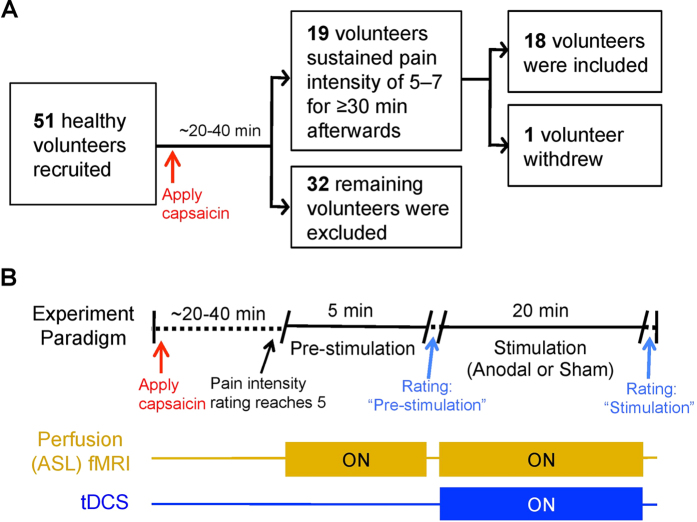
Experiment paradigm.(A) Fifty-one healthy volunteers were first screened for their response to topical application of 1% capsaicin cream on the right, medial calf. To achieve optimal temporal resolution, a continuous rating scale, anchored between 0 (none) and 10 (worst imaginable) was used to record the subject’s ongoing pain intensity. After capsaicin application for 20–40 minutes, only subjects who reached and maintained a tonic pain experience (pain intensity rating of 5–7 for ≥30 minutes; Supplementary Fig. 1) participated in the remainder of the study. One subject withdrew due to discomfort during a sham tDCS MRI session. (B) Eighteen capsaicin responders participated in two perfusion MRI sessions, one with anodal tDCS and one with sham tDCS, at least one week apart. The order of the experimental sessions was randomized and counterbalanced across the subject cohort. Capsaicin cream was applied as in the initial screening session. No subjects reported pain before the session commenced. Once the subject’s pain intensity rating reached a score of 5, which typically required 20–40 minutes, a 5-minute pre-stimulation ASL fMRI scan was performed followed by a 20-minute scan with concurrent tDCS (anodal or sham). Subjects’ pain ratings were verbally recorded after each scan using the same numerical rating scale, as above. Prior to ASL fMRI scans, subjects also underwent a DTI scan in a previous session on a different day.